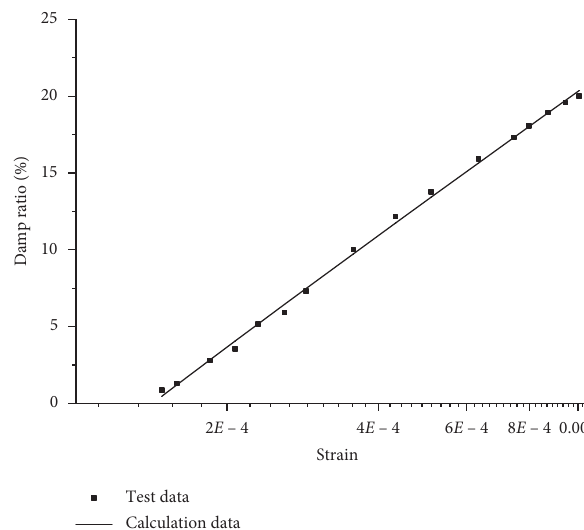
Figure 16: The relationship between λ